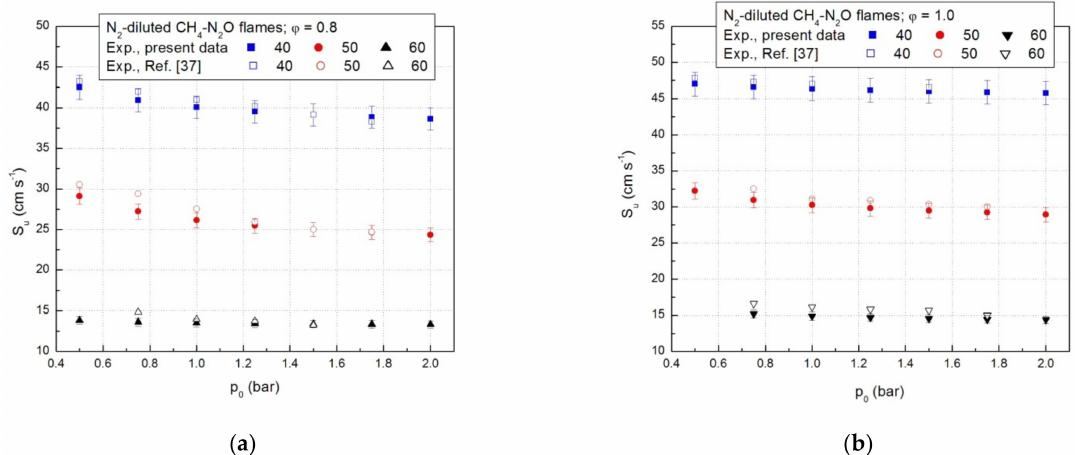
Figure 5. Laminar combustion velocities of CH 4 -N 2 O mixtures diluted with N 2 ; present results and literature data: ( a ) for equivalence ratio φ = 0.8 and ( b ) for equivalence ratio φ =